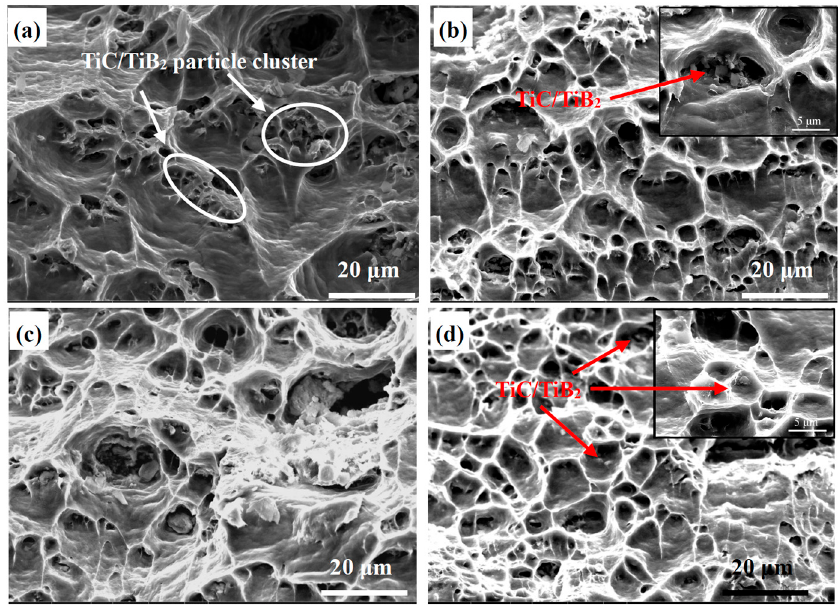
Figure 10. Fractography of Al-TiB 2 /TiC composites at higher magnification: ( a ) As cast; ( b – d ) After one, two and four ARB cycles, respectively.